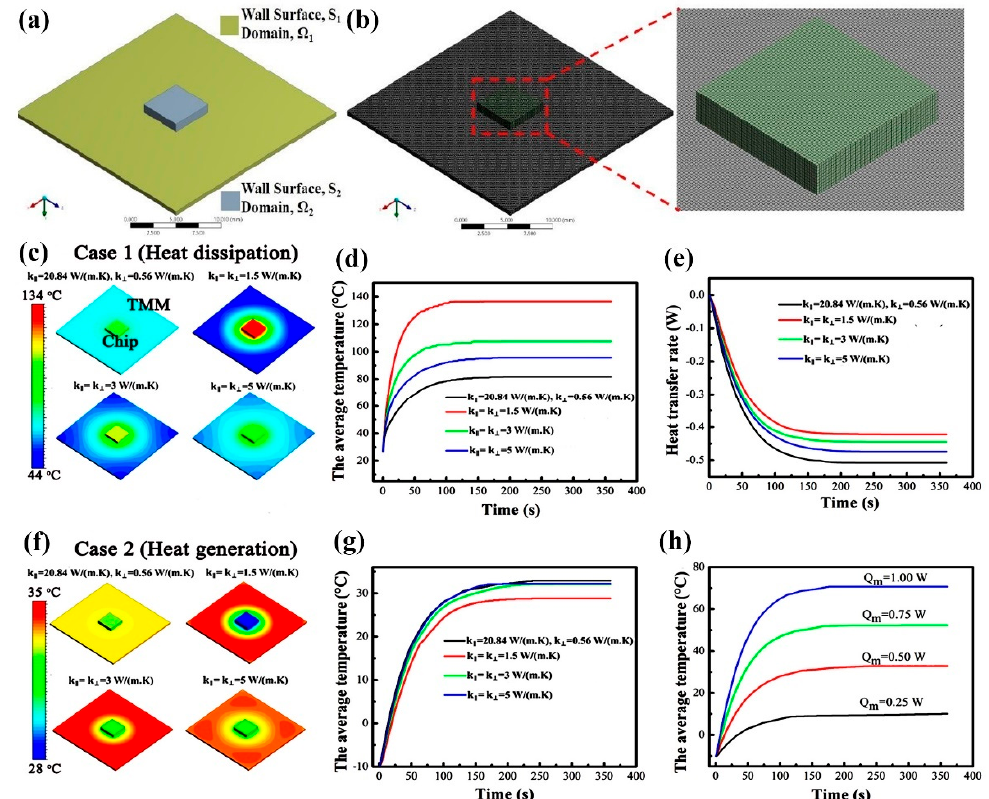
Figure 26. ( a ) The geometry and ( b ) the mesh used in the simulation. ( c , f ) Modeling and calculation of the temperature in case 1 and case 2, respectively. ( d ) Average temperature change of the chip with time and ( e ) the heat transfer rate through the thermal management material (TMM) surface with time when the chip is the heat source. ( g , h ) The change in the average temperature of the chip with time when the TMM is the heat source and different heat sources of TMMs (reproduced with permission from [199].